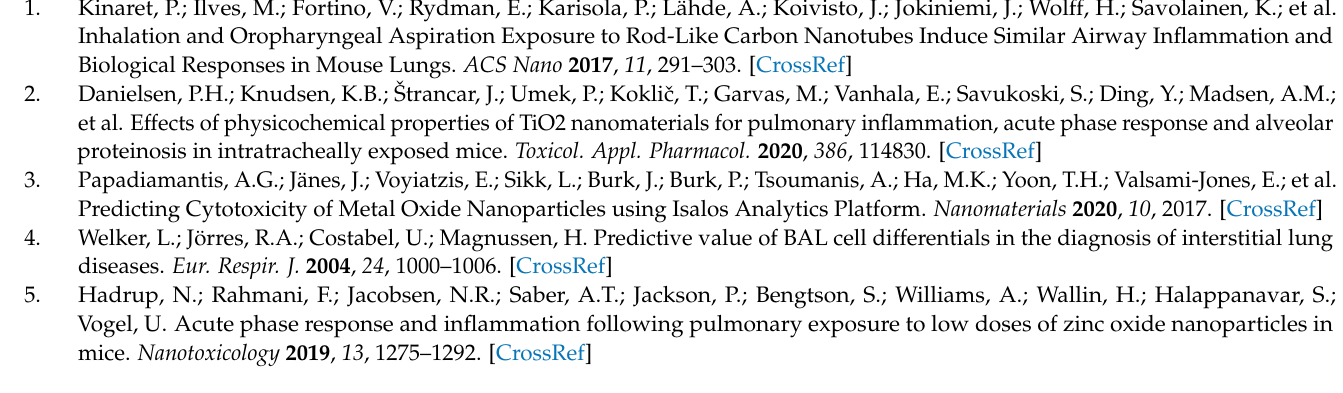
List of dynamic dose-dependent genes in TiO 2 ; Table S3: List of dynamic dose-dependent genes in CB; Table S4: List of dynamic dose-dependent genes in NM401; Table S5: List of dynamic dose-dependent genes in NRCWE26; Table S6: List of KEGG pathways enriched by the dynamic dose-dependent genes in TiO 2 ; Table S7: List of KEGG pathways enriched by the dynamic dose-dependent genes in CB; Table S8: List of KEGG pathways enriched by the dynamic dose-dependent genes in NM401; Table S9: List of KEGG pathways enriched by the dynamic dose-dependent genes in NRCWE26; Table S10: dynamic dose-dependent labels of the immune cell BAL counts; Table S11: List of KEGG pathways of the dynamic dose-dependent genes correlated with macrophages; Table S12: List of KEGG pathways of the dynamic dose-dependent genes correlated with neutrophils; Table S13: List of KEGG pathways of the dynamic dose-dependent genes correlated with eosinophils; Table S14: List of KEGG pathways of the dynamic dose-dependent genes correlated with